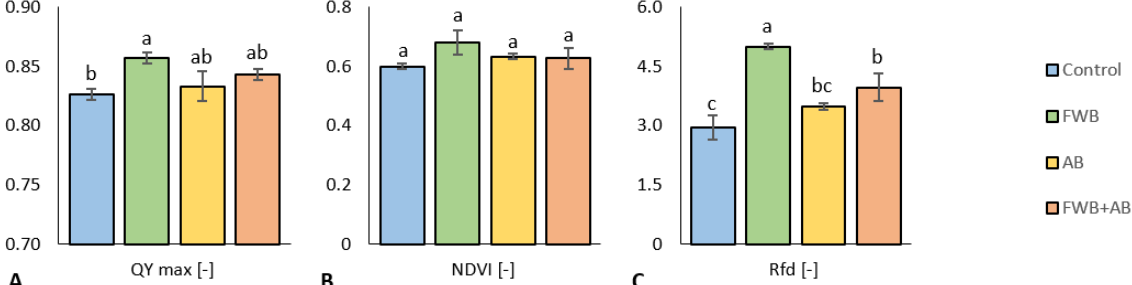
Figure 2. The responses of plant chlorophyll fluorescence characteristics under the applied amendments on ( A ) quantum yield of electron transport chain; ( B ) normalized difference vegetation index; and ( C ) chlorophyll fluorescence decrease ratio. Different lowercase letters indicate statistically significant differences within columns. n = 3.